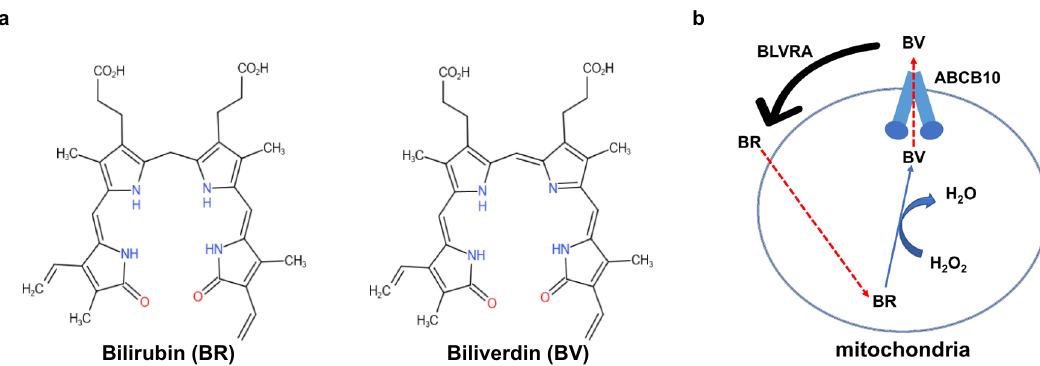
Fig. 1 | The biliverdin (BV)-bilirubin (BR) cycle. a Chemical structures of BV and BR. b Model representation of the BV-BR cycle. BV is exported by ABCB10 to cytosol where it is reduced into BR. BR can cross the mitochondrial membrane passively due to its high lipophilicity then oxidized by H 2 O 2 .